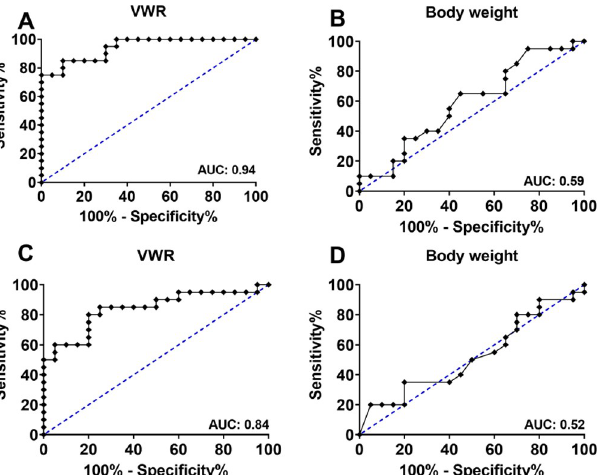
Fig 7. ROC curve analysis of well-being parameters. ROC curve analyses for the impact of surgery on VWR (A) and body weight (B) course and the impact of the first double injection procedure on VWR (C) and body weight (D) (n = 20).